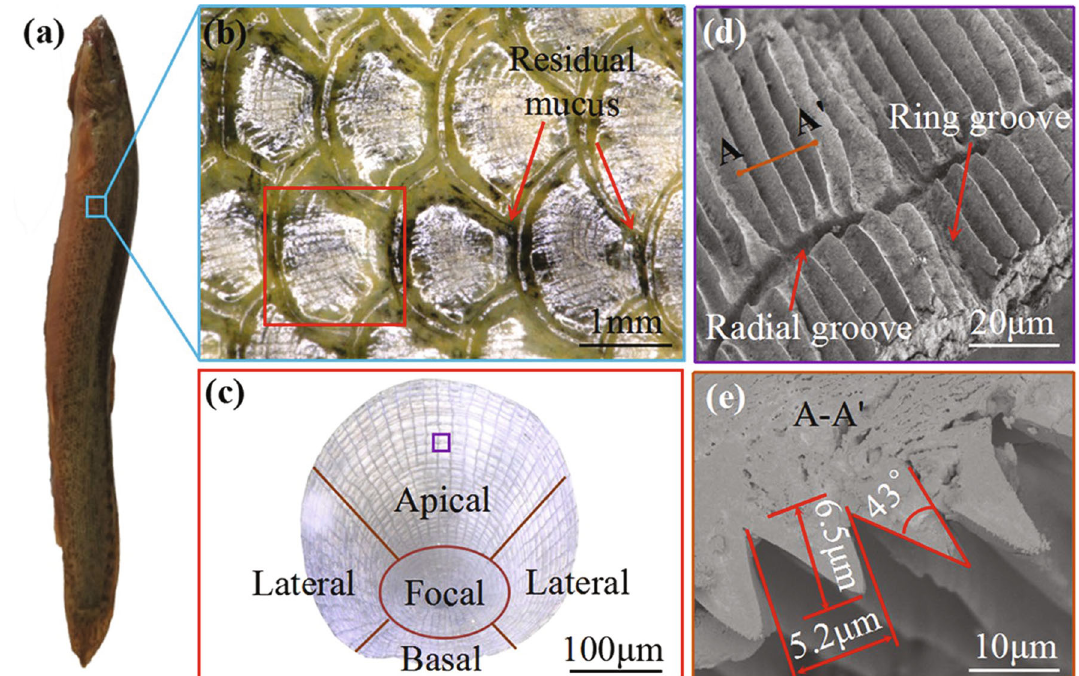
Figure 21: Microscopic morphology of loach body: (a) loach, (b) scale morphology, (c) di ff erent positions on the same scale, (d) groove structure, and (e) groove cross section